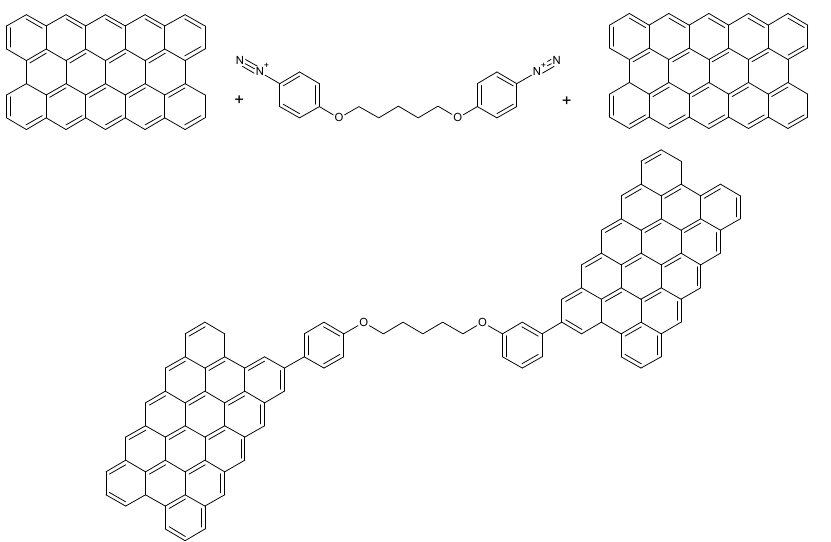
Figure 5. Binding graphene sheets using a bis-diazonium salt. From Reference [37] with permission of Wiley.